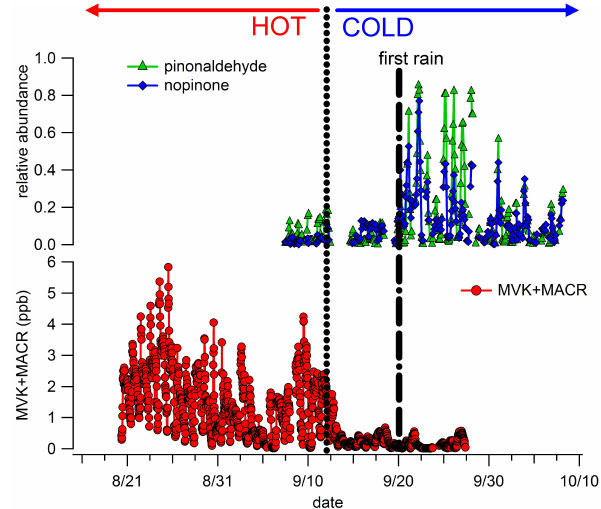
Fig. 5. Time series plots of the sum of methyl vinyl ketone and methacrolein (MVK+MACR) and particle phase biogenic oxida- tion tracers pinonaldehyde and nopinone as measured by TAG showing their varying behavior during the hot and cold periods and following the first rains in early